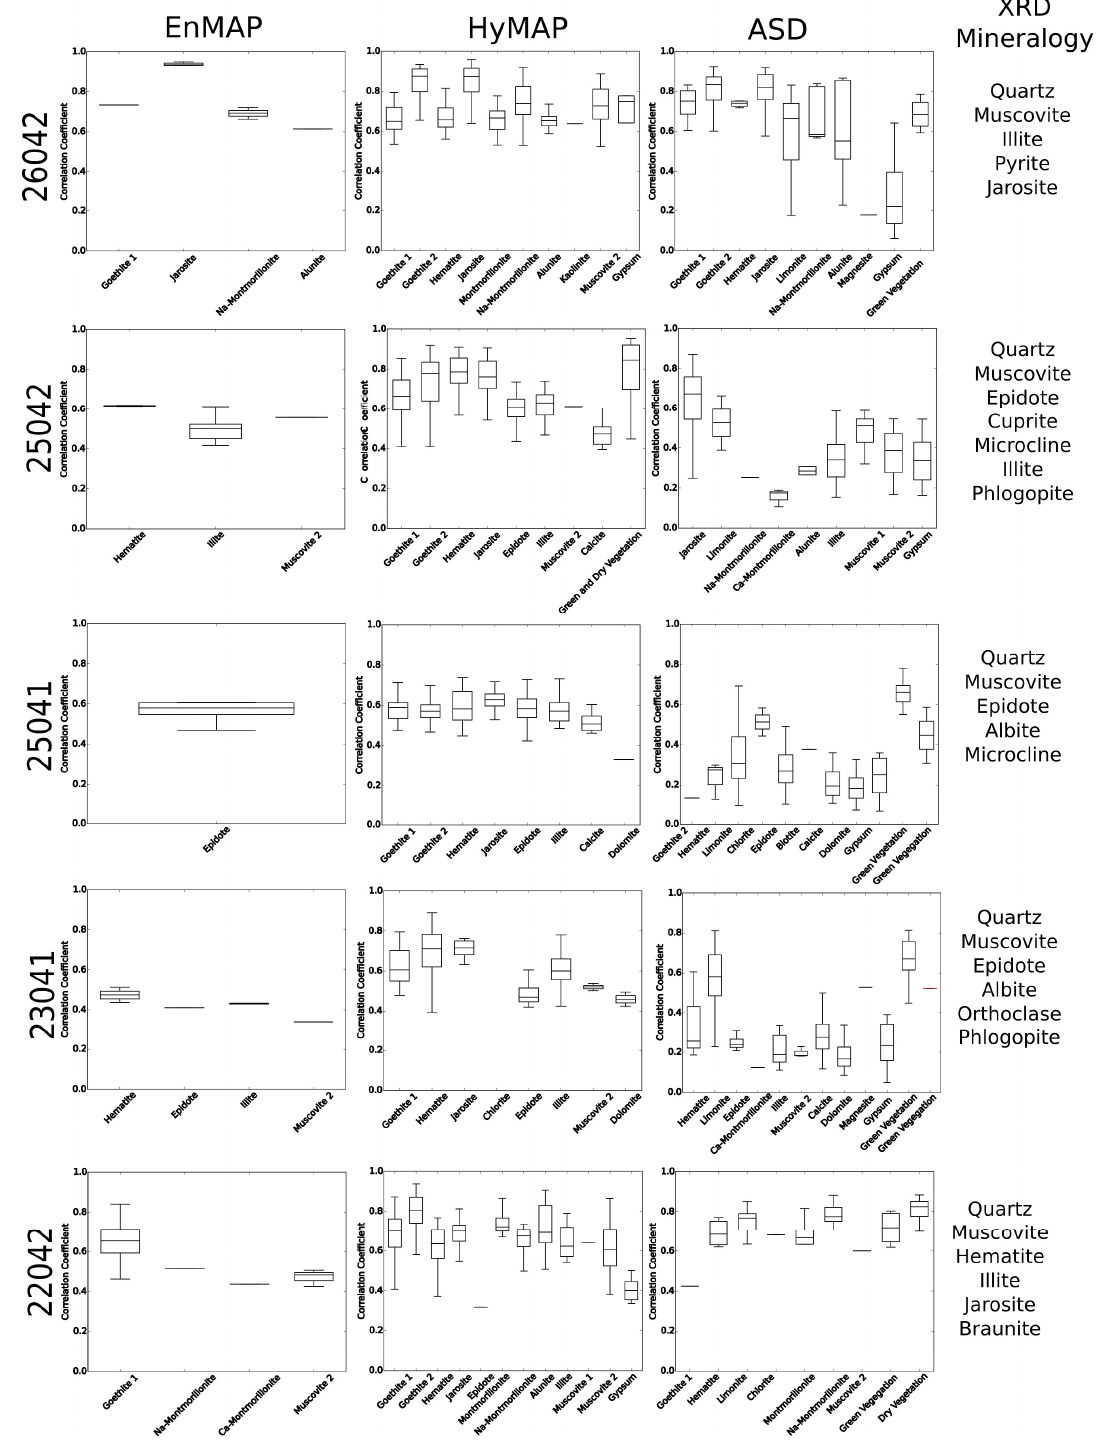
Figure 22. Boxplots showing the linear correlation values of the EnGeoMAP 2.0 detected materials at field validation sites from the Haib River area from simulated EnMAP data, HyMAP data and ASD field spectra together with analysis results from XRD data.